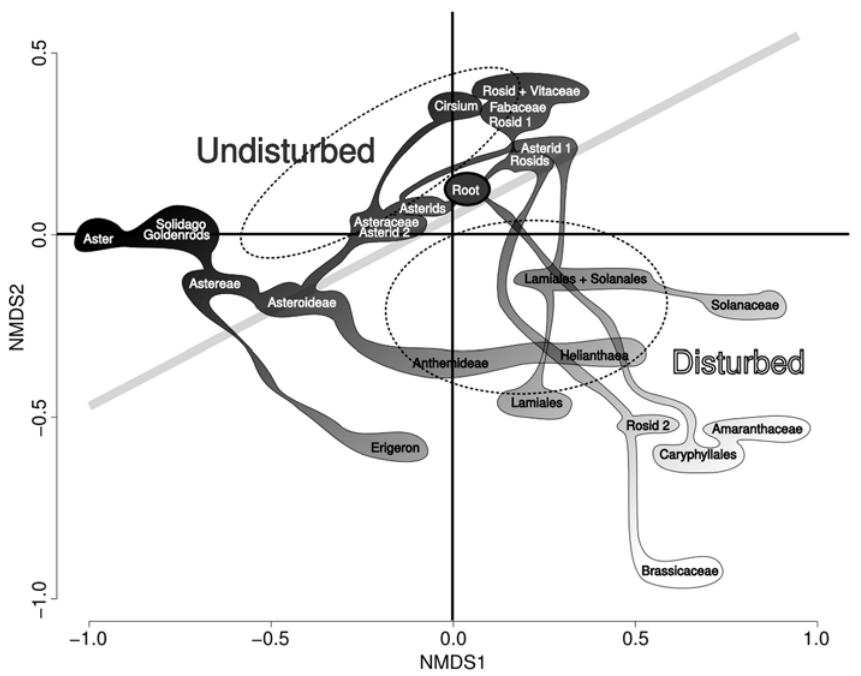
Figure 3. Non-metric multidimensional scaling scores for all phylogenetic nodes with reference to habitat occurrence tendency. Ordination plot for the phylogenetic ordination shown in figure 2b but with plot points removed and phylogenetic node vectors displayed. For clarity, only important or non-redundant nodes are displayed. Filled bubbles are a rough representation of the branching structure of the nodes from one another. Dark filling represents more association with undisturbed plots whereas lighter filling represents more association with disturbed plots. Dotted ellipses represent the centroids and 1 SD area as a reference for where disturbed and undisturbed plots fall on the diagram. Nodes which are referred to can be seen on figure 1.